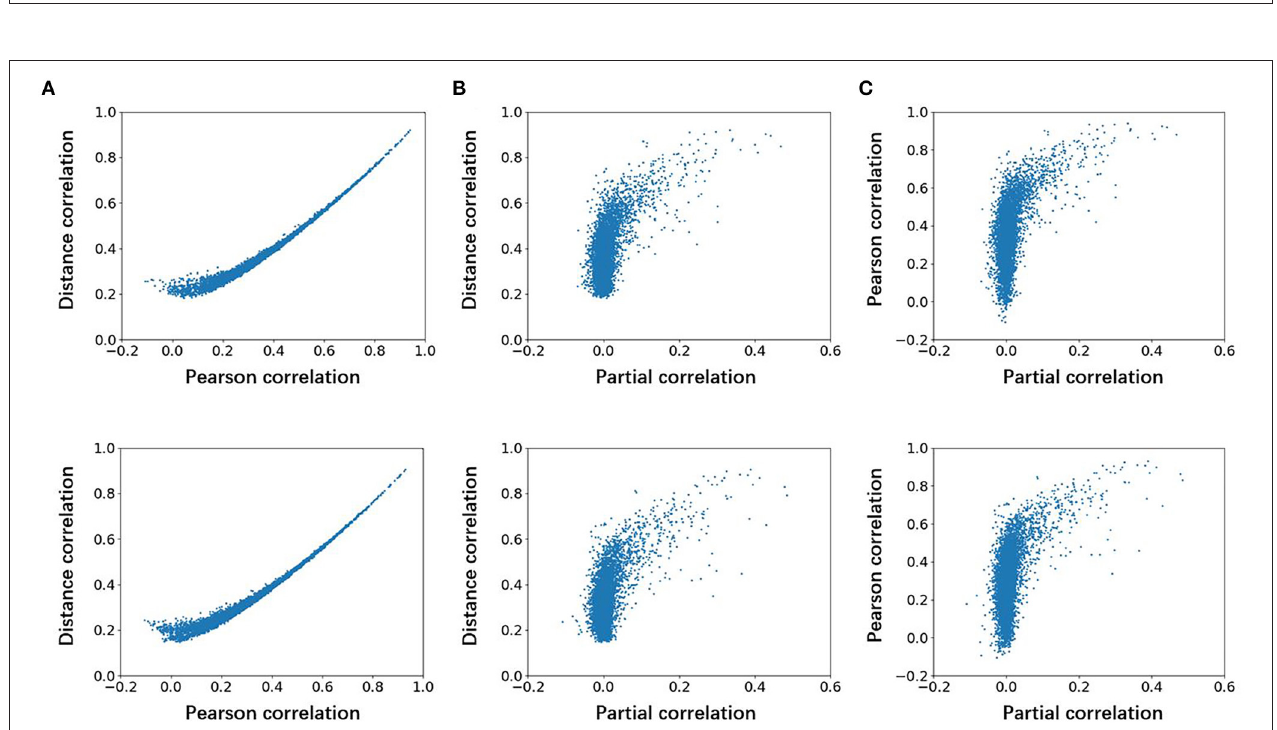
FIGURE 3 | Scatter plots of association among the Pearson, partial, and distance correlations for average functional connectivity across the participants. The first row is for HCS and the second row is for the patients with OCD. (A) Distance correlation vs. Pearson correlation, (B) distance correlation vs. partial correlation, and (C) pearson correlation vs. partial correlation. OCD, obsessive-compulsive disorder; HCS, healthy control subject.